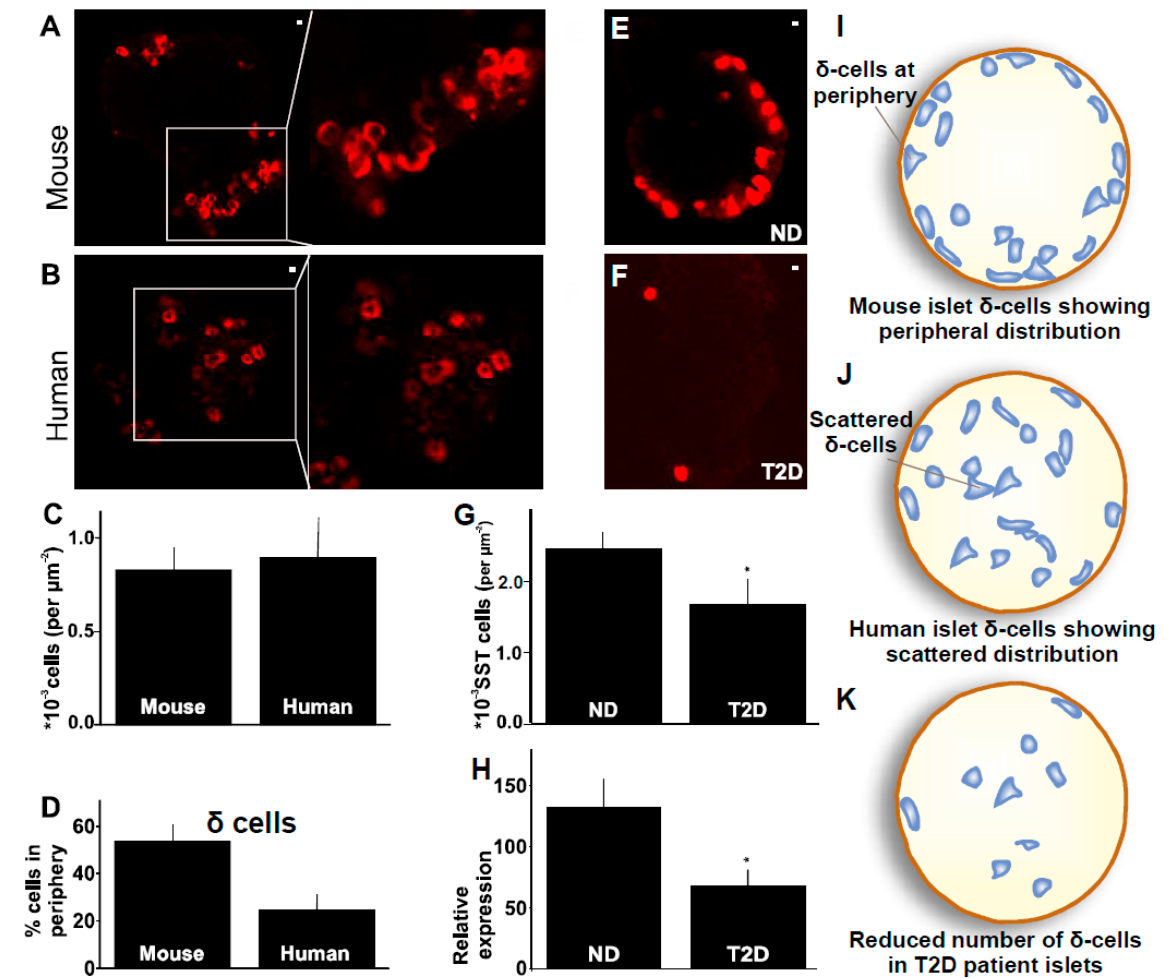
Figure 5. Distribution of δ -cells in mouse compared to human islet, how this distribution is affected during human T2D—( A ) A mouse islet stained with SST antibody. Inset shows peripherally distrib- uted δ -cells (Scale bar = 1 µm), ( B ) A human islet stained with SST antibody. Inset shows scattered δ -cells (Scale bar = 1 µm), ( C ) Total number of δ -cells in an islet. Each experiment was repeated on at least 5 islets on two different days using 2–4 mice or 3 donor islets respectively, ( D ) Percentage of cells distributed in the periphery of the islet. Each experiment was repeated on at least 5 islets on two different days using 2–4 mice or 3 donor islets respectively, ( E ) Distribution of δ -cells in an islet from non-diabetic donor (Scale bar = 1 µm), ( F ) Distribution of δ -cells in an islet from T2D donor (Scale bar = 1 µm), ( G ) Total number of δ -cells per islets from T2D or non-diabetic donors. Each experiment was repeated on at least 5 islets using 3 donor islets (received on sperate days) for ND or T2D respectively, ( H ) Relative expression of SST in islet tissue in comparison with housekeeping genes in non-diabetic and T2D donor islets. Each experiment was repeated on at least 5 islets using 3 donor islets (received on sperate days) each for ND or T2D respectively, ( I ) Cartoon representation for peripheral distribution of δ -cells in mouse islets, ( J ) Cartoon representation for scattered distri- bution of δ -cells in human islets, ( K ) Cartoon representation for reduced number of δ -cells in T2D patient islets. (* p < 0.05). 2.4. δ -Cells in Human Type-2 Diabetes The distribution of β - and α -cells has been extensively investigated and documented in non-diabetic islets compared to the T2D diabetic islets [21] but the distribution of δ -cells has not been studied in the T2D. Here, we investigate the δ -cell distribution with δ -cell